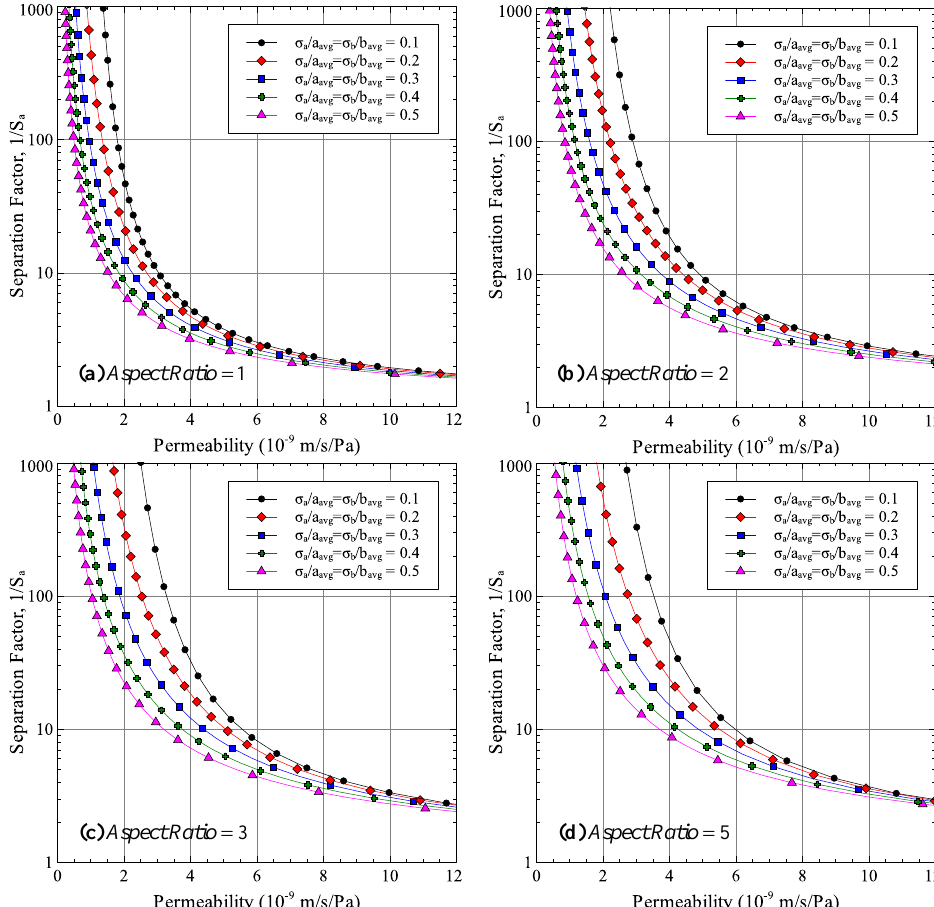
Figure 3. Effect of pore size distribution on permeability-selectivity trade-off.